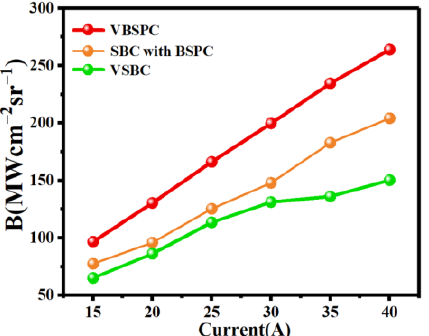
Figure 5. The brightness of SBC (green), SBC with BSPC (yellow), and VBSPC (red) with respect to the injection current.